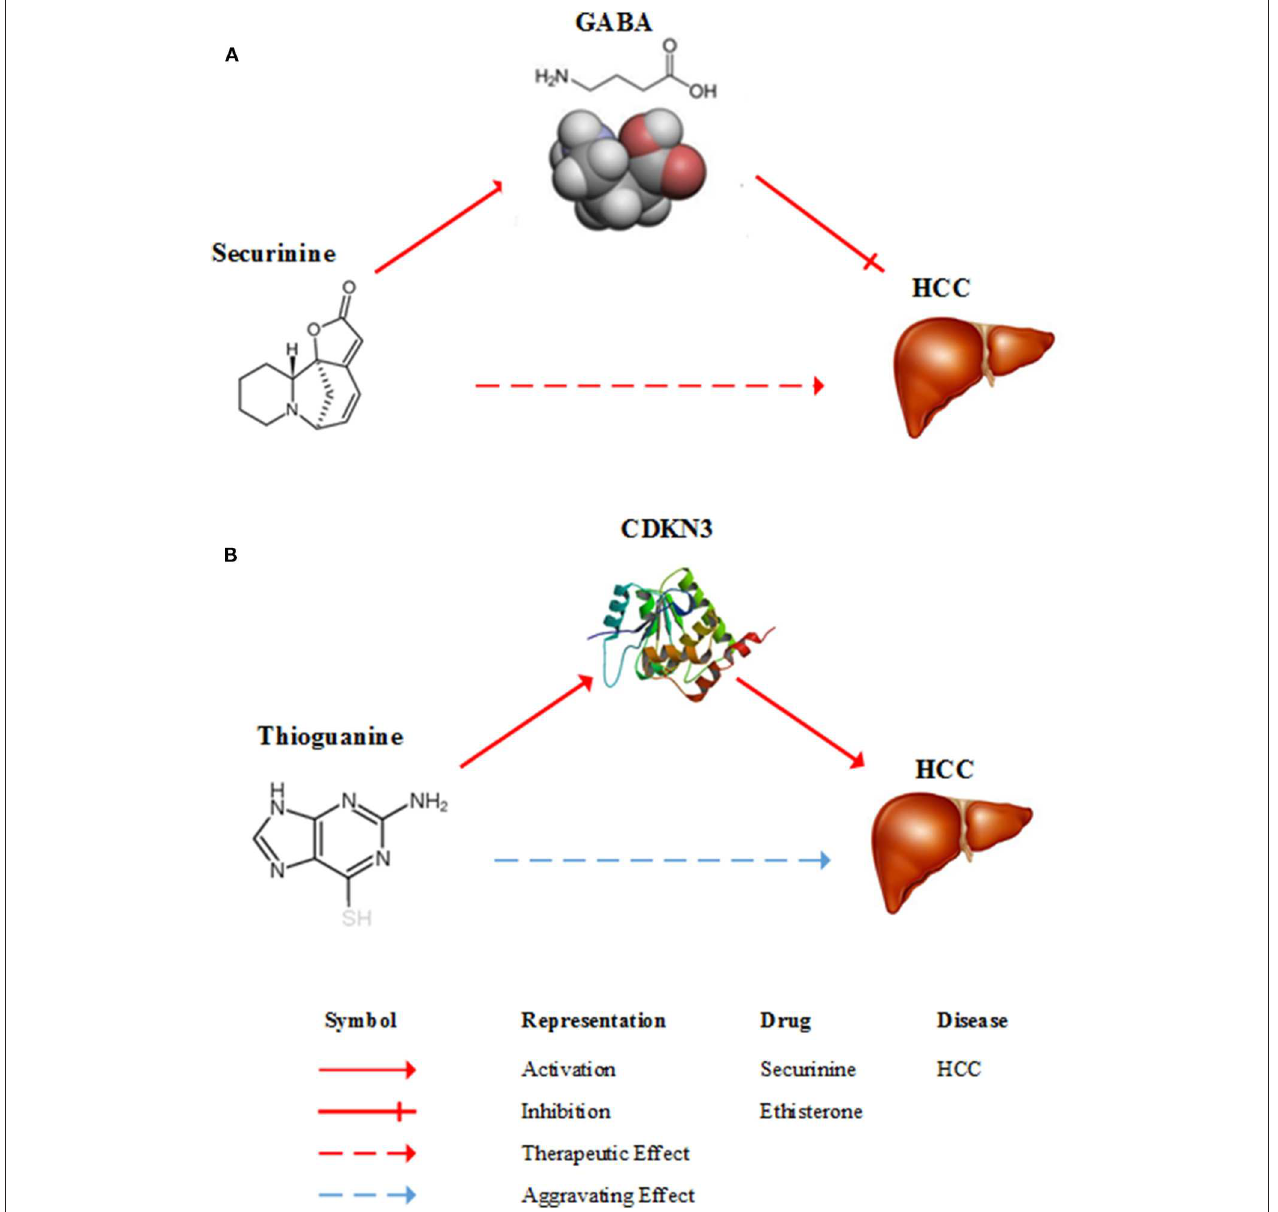
FIGURE 3 | Diagrams of the possible mechanism of between HCC and two drugs. (A) A possible mechanism of securinine treating HCC. Securinine has been found to be active as a γ -amino butyric acid (GABA) receptor antagonist. GABA stimulates HCC cell line HepG2 growth. Consequently, it means that securinine is a promising agent with therapeutic effect on HCC patients through inhibiting GABA receptor. (B) A possible mechanism of thioguanine aggravating HCC. Thioguanine is a guanine analogs and it can decrease the expression of CDKN3. But, CDKN3 gene inhibits tumor growth by controlling mitosis. Hence, thioguanine may get aggravating effect on HCC